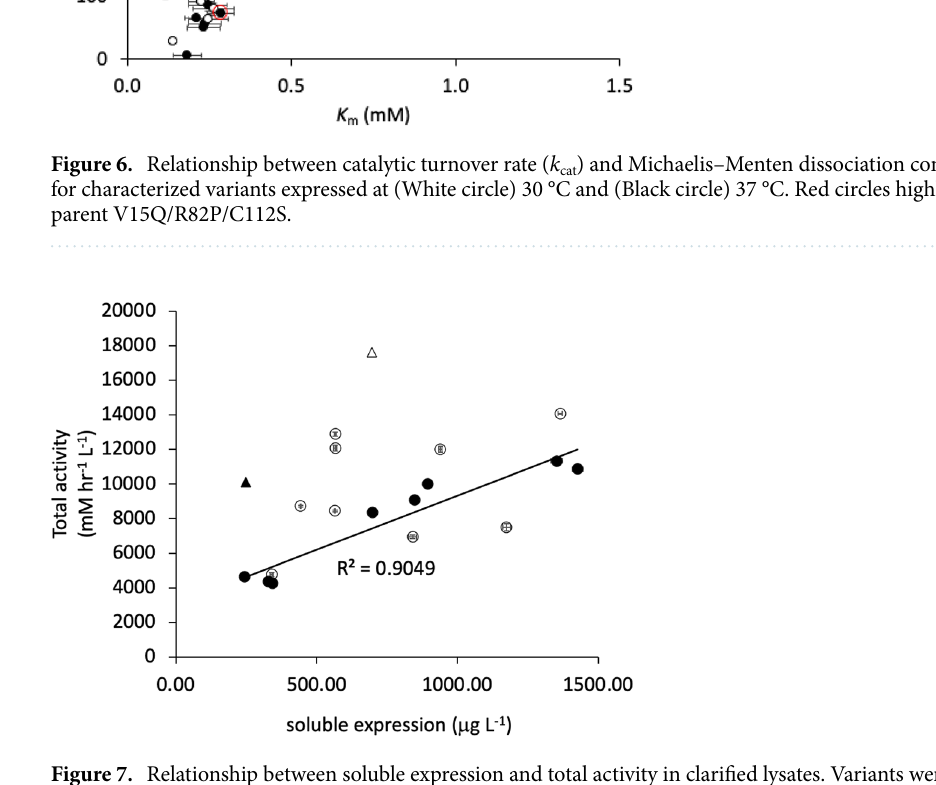
Figure 7. Relationship between soluble expression and total activity in clarified lysates. Variants were expressed at (White Circle) 30 °C or (Black Circle) 37 °C. WLEK0699 is shown separately as triangles from expression at (White Triangle) 30 °C or (Black Triangle) 37